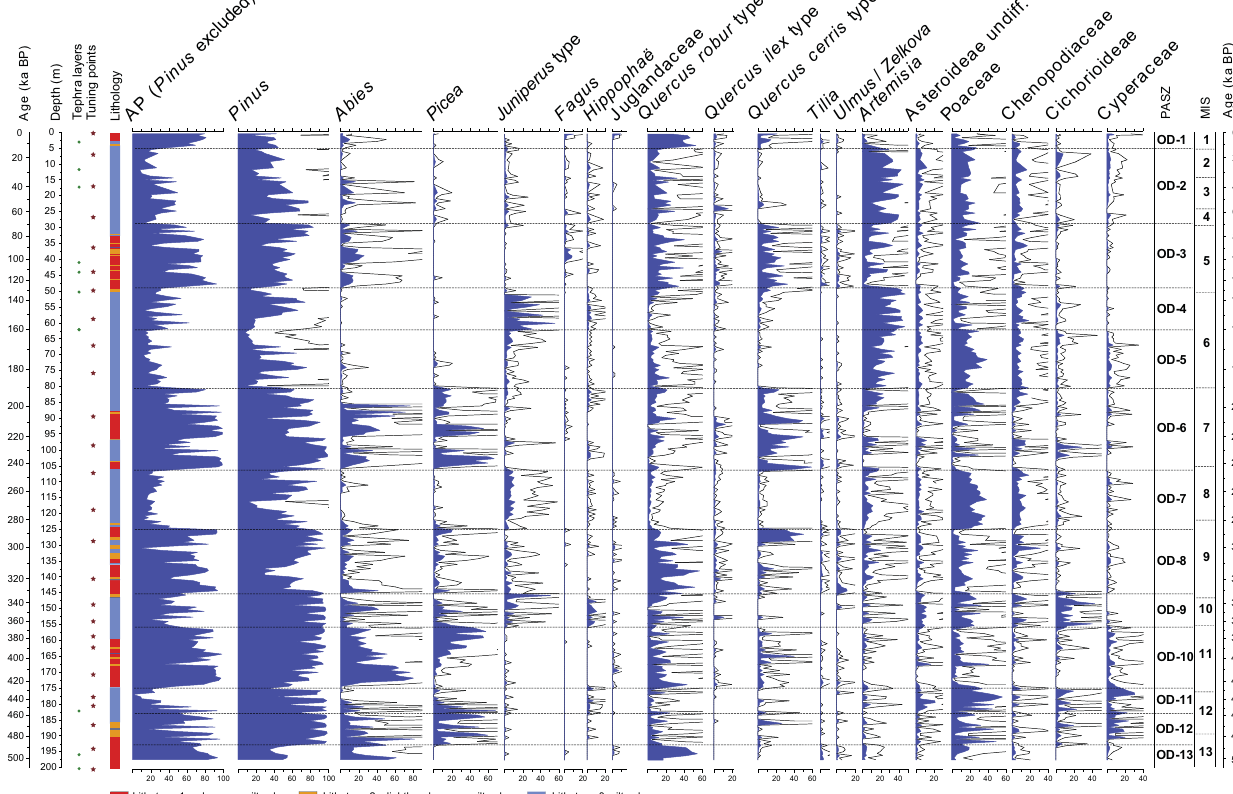
Figure 2. Lake Ohrid (FYROM), DEEP core. Pollen percentage diagram of selected taxa against depth scale. Lithology, tephra layers and tuning points adapted from Francke et al.